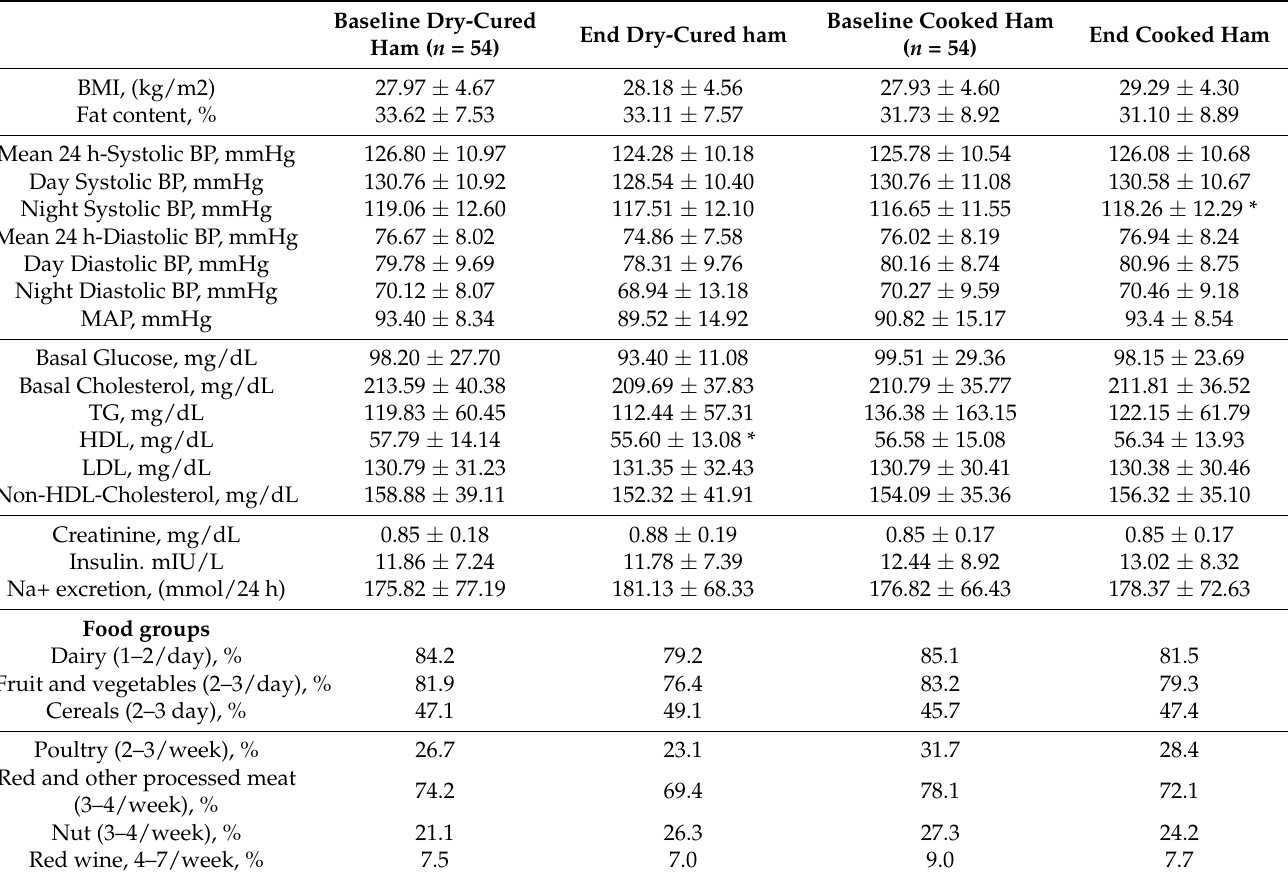
Table A1. Changes in anthropometric, hemodynamic, biochemical data and food groups intake from baseline to end of treatment, expressed as mean ± standard